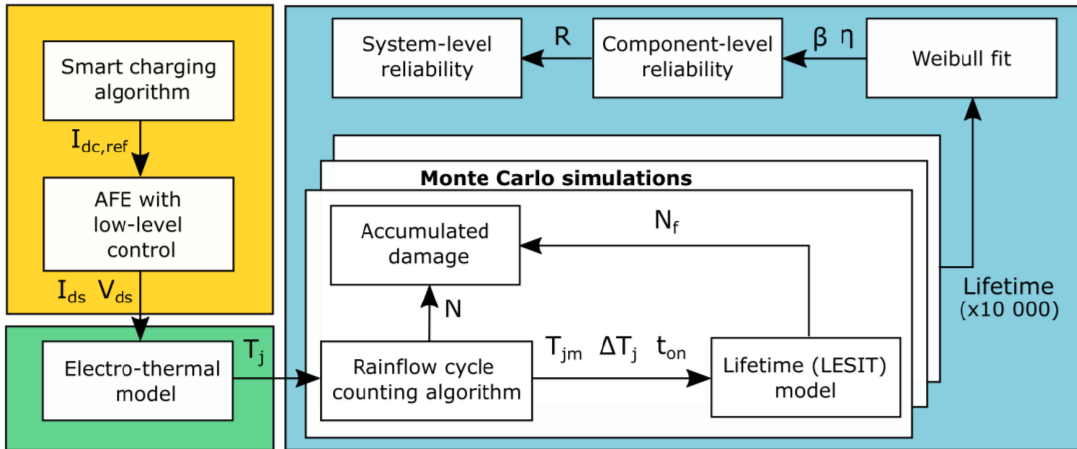
Figure 5. Stepwise reliability estimation method for the considered charging system.